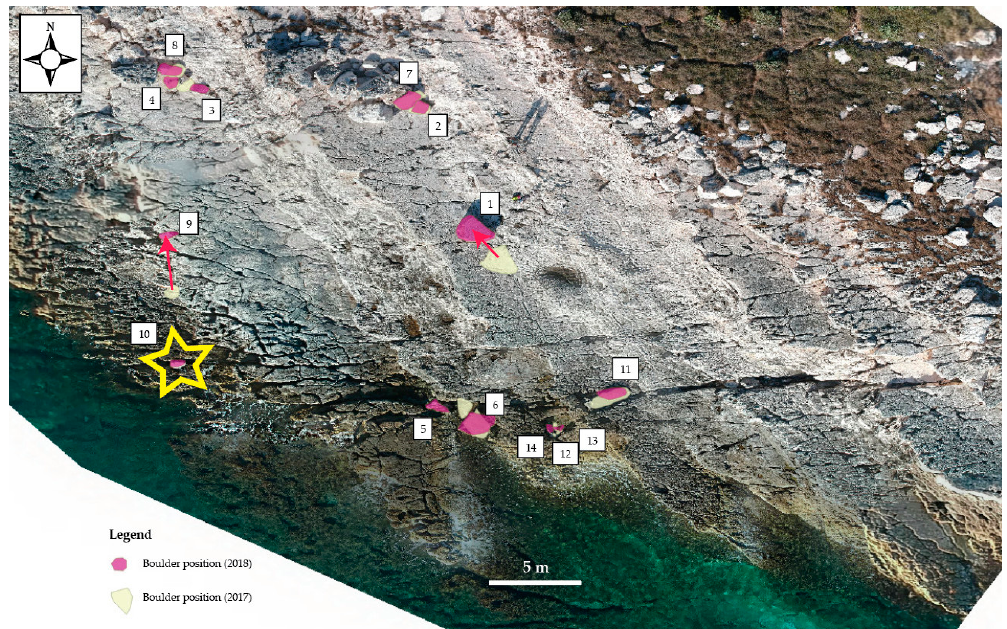
Figure 4. Spatial distribution of 14 boulders affected by the 29 October storm Vaia. The base image was taken during the November 2018 UAV flight. The star indicates the presence onshore of a new limestone boulder detached and moved from the seafloor during the storm. No movements were recorded after 15 November 2018, and 30 April 2019.